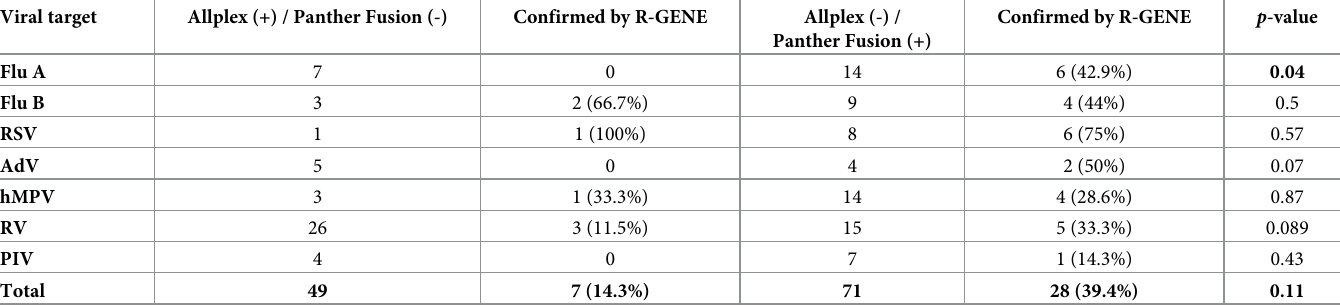
Table 7. Discordant results between Allplex and Panther Fusion and results obtained with the reference method (R-GENE). Viral target Allplex (+) / Panther Fusion